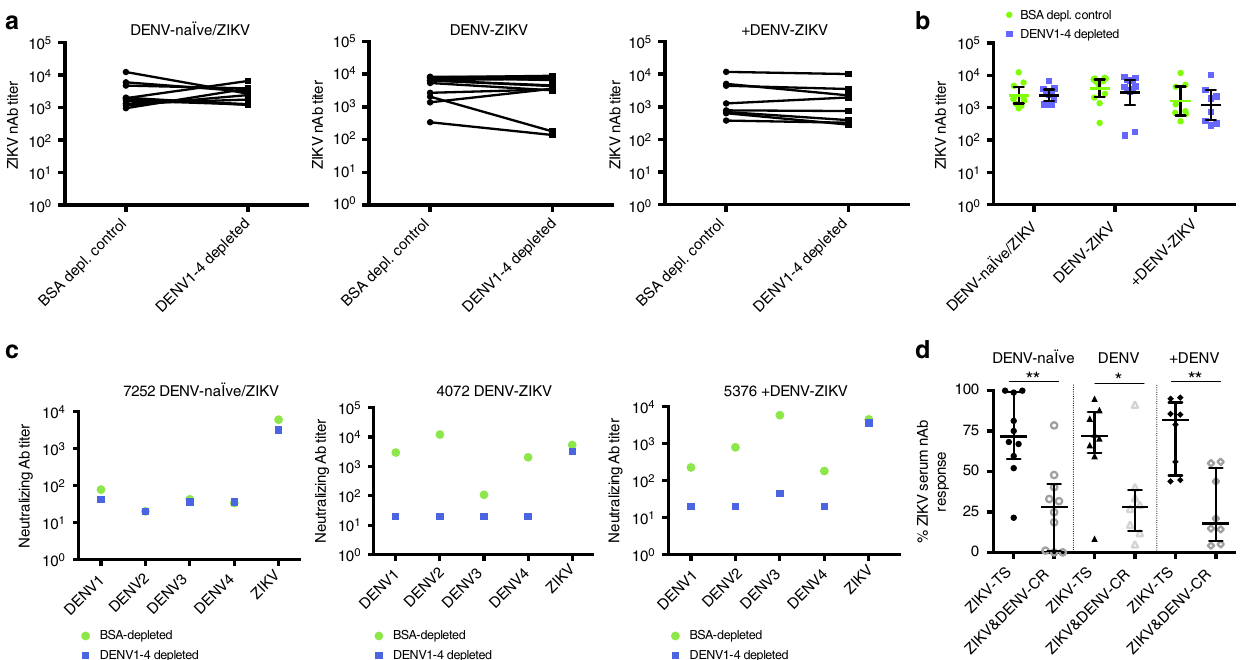
Fig. 6 Depletion of DENV antibodies in serum does not have a signi fi cant effect on ZIKV neutralization. Neutralization analysis of DENV-depleted serum samples from ZIKV-infected patients with no (DENV-naïve/ZIKV), one (DENV-ZIKV), or more than one ( + DENV-ZIKV) prior DENV infection. a ZIKV neutralizing antibody titer (FRNT 50 ) in DENV-depleted versus control (BSA)-depleted samples for each group of ZIKV-infected patients at ~8 months postinfection. Lines connect results from each individual. b Statistical analysis of ZIKV neutralizing titers before and after depletion of DENV-reactive antibodies at ~8 months postinfection. Statistical analysis was performed by Wilcoxon test, but no signi fi cance differences were found among nondepleted and DENV-depleted ZIKV neutralizing antibody titers. c ZIKV neutralization antibody titers before and after depletion of DENV-reactive antibodies from three representative subjects analyzed in a . d Analysis of ZIKV type-speci fi city (TS) and ZIKV and DENV cross-reactivity (CR) in total ZIKV neutralizing response. Median and IQR is shown for d , and signi fi cance was determined by Mann – Whitney test. * p < 0.05, ** p < 0.01, *** p < 0.001. Neutralizing antibody titers were log 10 transformed for the analysis of a – c . DENV-naïve/ZIKV, n = 10; DENV-ZIKV, n = 10; + DENV-ZIKV, n =